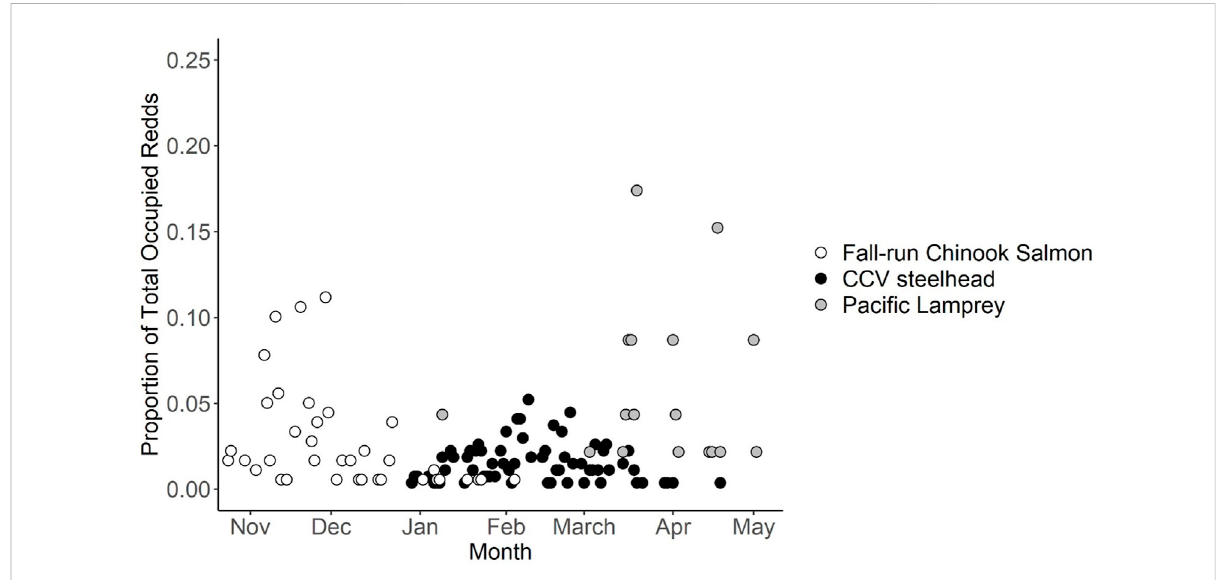
FIGURE 3 Temporal distribution of proportion of redds observed occupied by either Fall-run Chinook Salmon, CCV steelhead and Paci fi c Lamprey between 2003 and